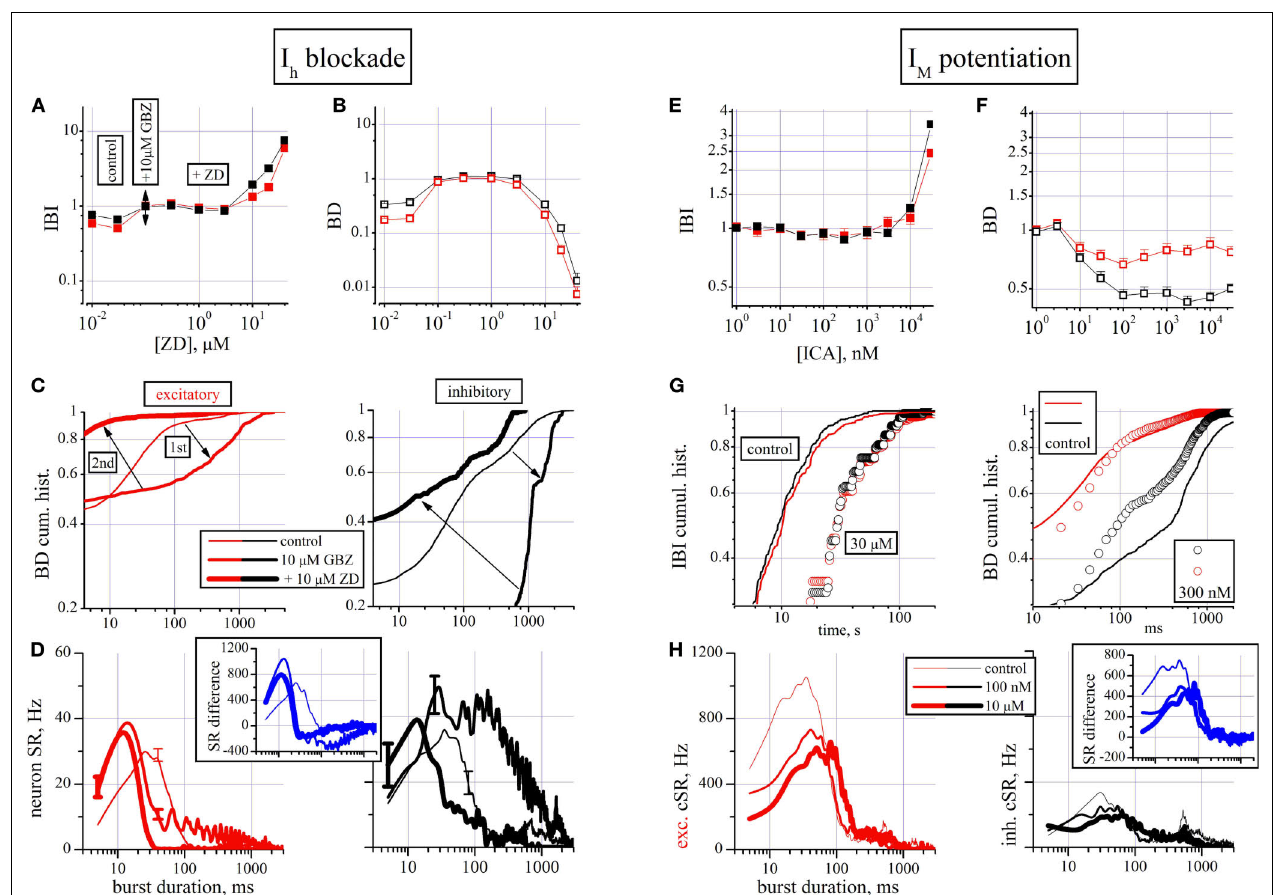
FIGURE 4 | The effects of blocking I (with ZD7288) and enhancing I (with top, respectively. Inset illustrates the cSR difference between excitatory and h M ICA-27243) currents. (A–D) Effects of ZD. (A,B) Dose–response curves for IBI inhibitory clusters. (E–H) Effects of ICA-27243. (E,F) Dose–response curves and BD evaluated for the excitatory (red symbols) and inhibitory (black for IBI and BD evaluated for the excitatory (red symbols) and inhibitory (black symbols) cluster of neurons (total number of cells: 192, 45, respectively). symbols) clusters of neurons (total number of cells: 190, 52, respectively). (C) BD cumulative histogram data from one of the three experiments with 36 (G) Cumulative histogram of IBI (left) and BD (right), respectively for excitatory excitatory (left) and 13 inhibitory (right) cells. Arrows indicate the temporal (red) and inhibitory (black) cells in control and at the indicated concentrations. sequence during the experiment. For the single experiment shown, mean For the single experiment shown, mean values of IBI and BD (in parenthesis values of IBI and BD (in parenthesis the inhibitory cells) in control were, the inhibitory cells) in control were, respectively: 17.1 ± 2.3 s (12.1 ± 0.6); respectively: 8.3 ± 0.3 s (7.4 ± 0.3); 61 ± 7 ms (405 ± 68), n = 36 ( n = 13). The 98 ± 14 ms (619 ± 82 ms), n = 52 ( n = 14); in 100 nM ICA: 16.2 ± 2.4 s values in 10 µM GBZ were: 10.2 ± 0.4 s (15.5 ± 0.6); 374 ± 60 ms (1430 ± 0.8) (11.8 ± 1.2 s); 64 ± 8 ms (280 ± 30 ms); in 10 µM ICA: 19.6 ± 2.9 s and in 10 µM ZD were: 22.2 ± 1.3 s (19.2 ± 0.75); 70 ± 17 ms (450 ± 61). (14.9 ± 0.7 s); 86 ± 10 ms (260 ± 20 ms). (H) Plot of cSR in excitatory (left) and (D) nSR (neuron-normalized cSR in each cluster) is plotted versus burst inhibitory (right) cells in control (thin lines), at 100 nM (medium lines) and at duration, for excitatory (left) and inhibitory (right) typical cells. Thin, medium 10 µM ICA (thick lines), respectively. Inset: the difference of SR between and thick lines are used to distinguish control, 10 µM GBZ and 10 µM ZD on excitatory and inhibitory